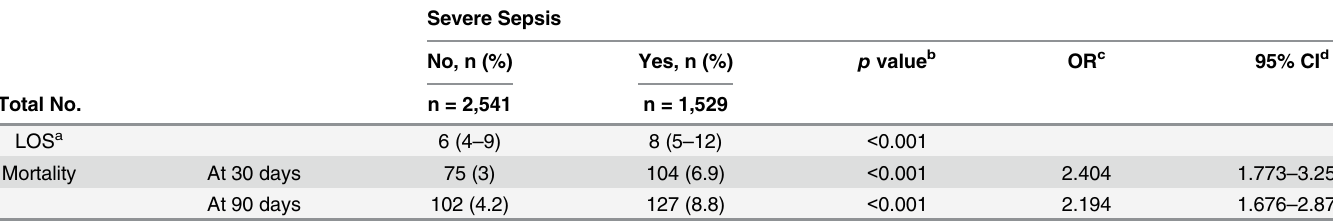
Table 2. Length of stay and mortality in CAP with regard to severe sepsis.